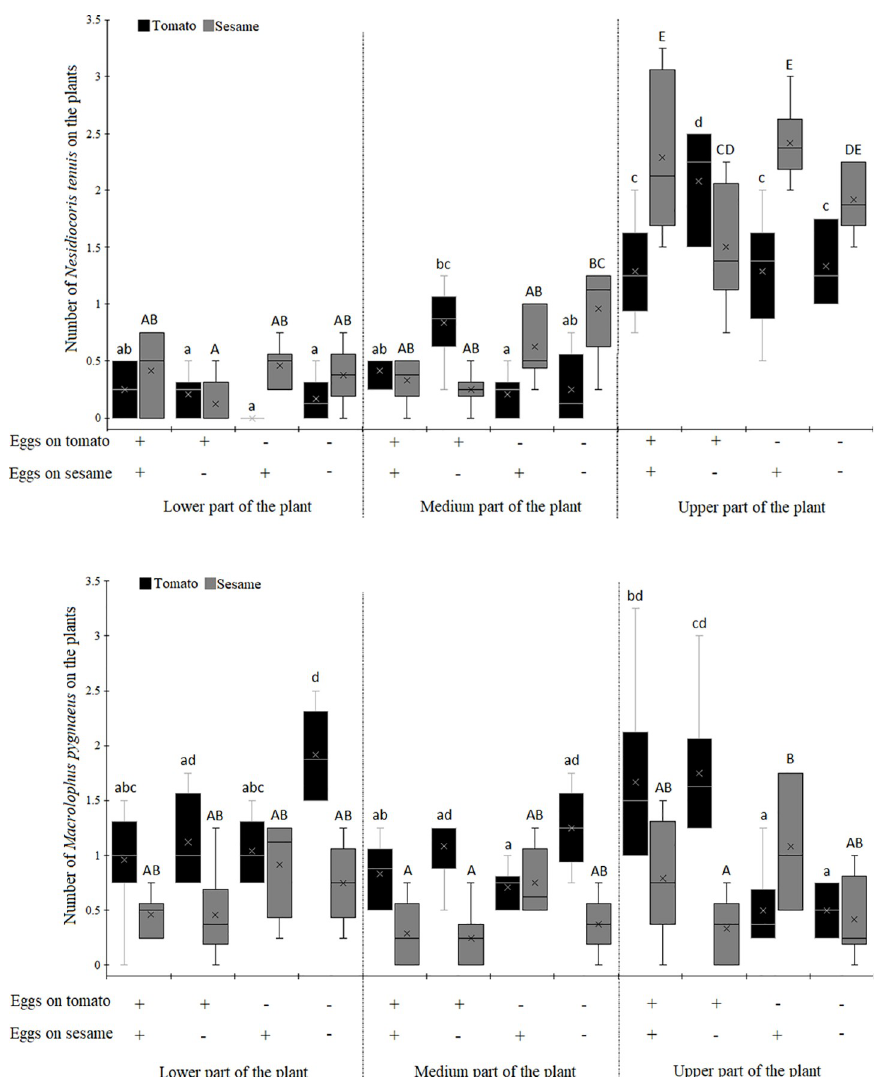
Fig 4. A. Number of Nesidiocoris tenuis on the different parts of the tomato or sesame plants depending on the presence or absence of Ephestia kuehniella eggs on the tomato or the sesame plant. The ‘+’ indicates the presence and the ‘-’ indicates the absence. Boxplot followed by the same lower or upper case letter did not differ significantly with respect to plant species (tomato and sesame, respectively). B. Number of predators Macrolophus pygmaeus on the different parts of the tomato or sesame plants depending on the presence or absence of Ephestia kuehniella eggs on the tomato or the sesame plant. The ‘+’ indicates the presence and the ‘-’ indicates the absence. Boxplot followed by the same lower or upper case letter did not differ significantly with respect to plant species (tomato and sesame,